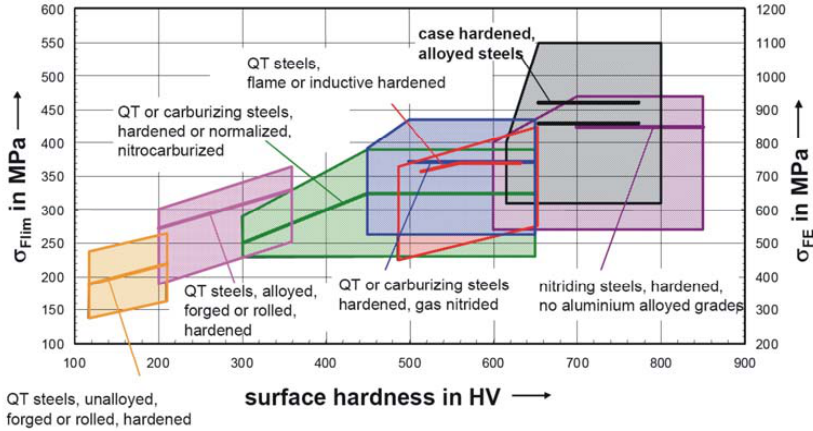
Figure 2. Tooth root load carrying capacity; allowable bending stress numbers according to ISO 6336-5 and the indication of quality levels (ML, MQ, ME) [6].